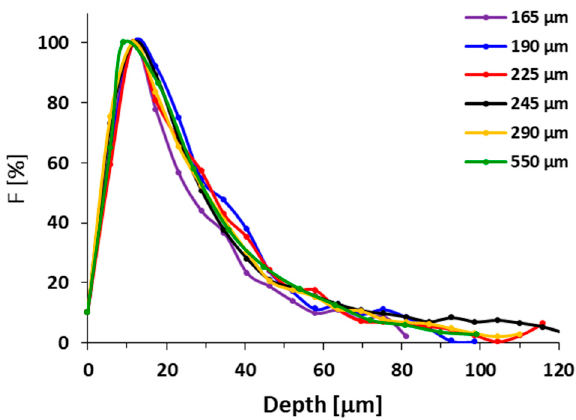
Figure 3. Fluorescence profiles of fluorescently labeled L1-Dy conjugate in U87-MG tumor spheroids of different diameters after 24 h.